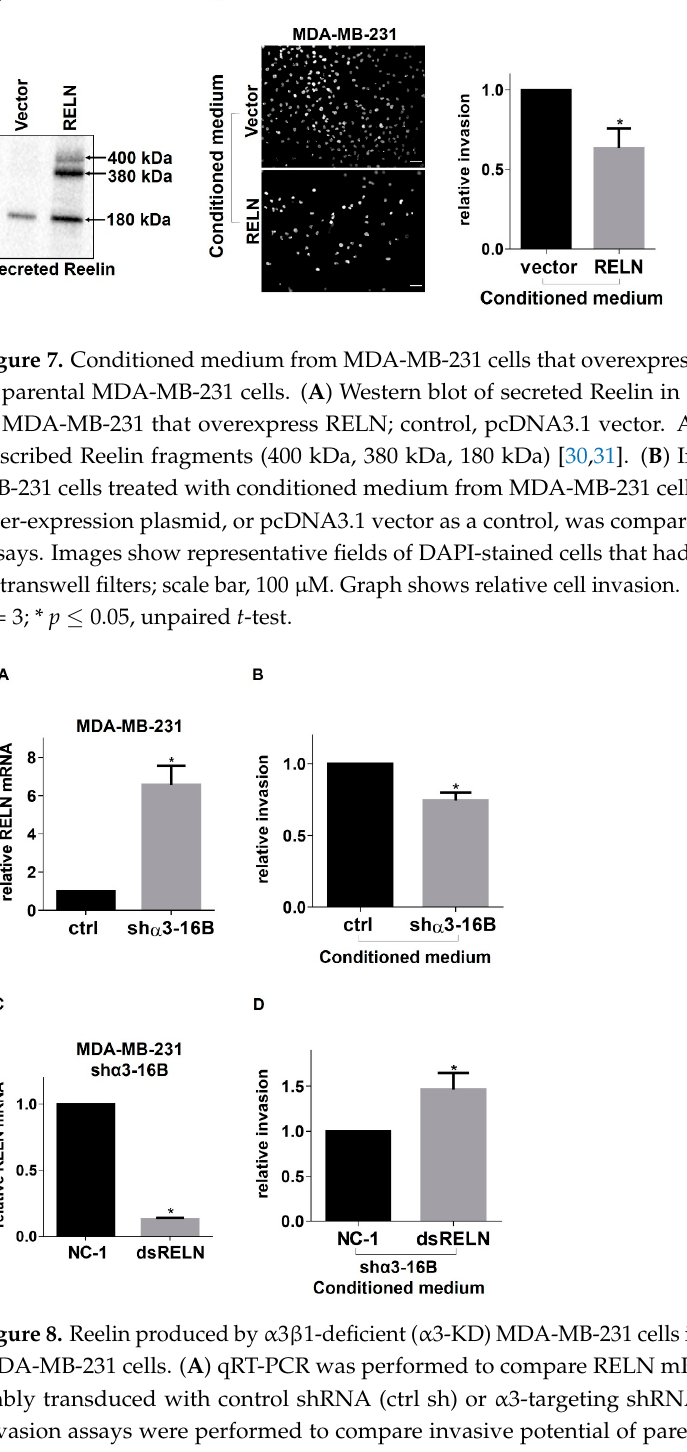
Figure 8. Reelin produced by α 3 β 1-deficient ( α 3-KD) MDA-MB-231 cells inhibits invasion of parental MDA-MB-231 cells. ( A ) qRT-PCR was performed to compare RELN mRNA in MDA-MB-231 cells stably transduced with control shRNA (ctrl sh) or α 3-targeting shRNA (sh α 3-16B). ( B ) Matrigel invasion assays were performed to compare invasive potential of parental (i.e., α 3 β 1-expressing) MDA-MB-231 cells in the presence of conditioned medium from control (ctrl sh) or α 3-KD (sh α 3-16B) MDA-MB-231 cells. ( C ) qRT-PCR was performed to compare RELN mRNA in α 3-KD (sh α 3-16B) cells transfected with either control (NC-1) or RELN-targeting (dsiRELN) dicer siRNA. ( D ) Matrigel invasion assays of α 3-KD (sh α 3-16B) MDA-MB-231 cells in the presence of conditioned medium from α 3-KD (sh α 3-16B) cells that were transfected with either control (NC-1) or RELN-targeting (dsiRELN) dicer siRNA. Data are average +/ − SEM, n = 3; * p ≤ 0.05, unpaired t